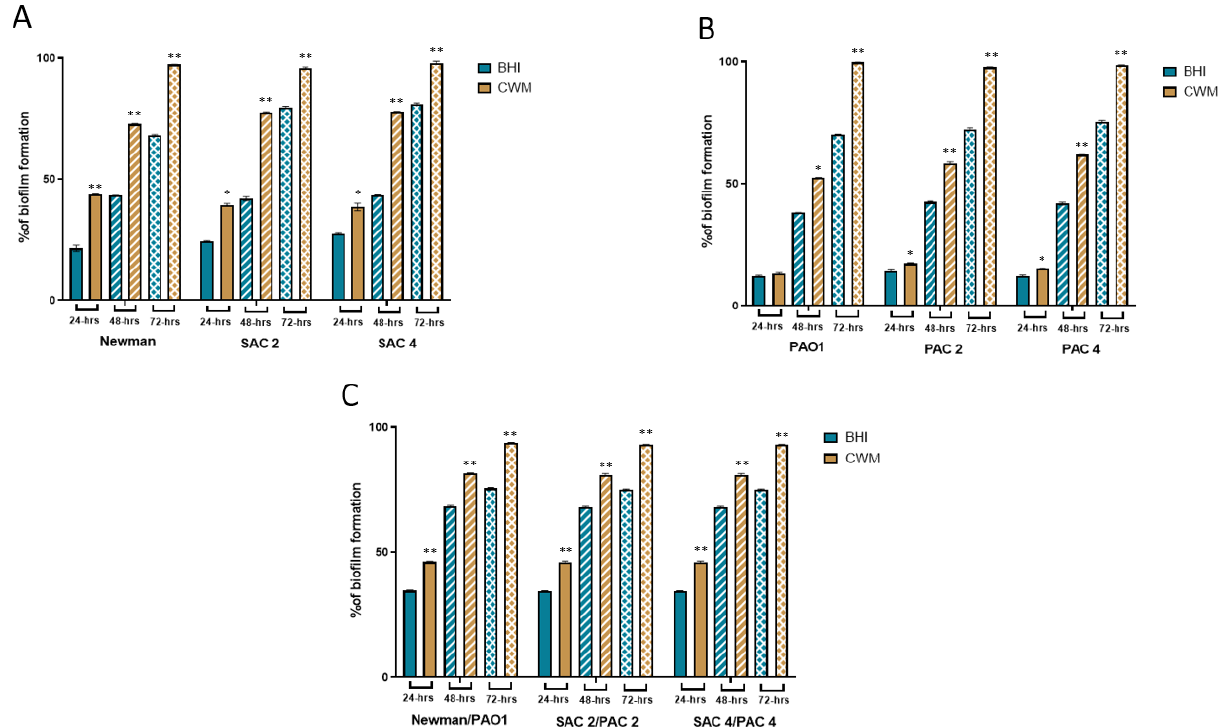
Figure 1. Kinetics of biofilm formation of S. aureus and P. aeruginosa strains used alone or in combina- tion in the BioFlux TM 200 system. ( A ) Percentages of biofilm formed in the microfluidic channel of the reference S. aureus Newman and two clinical S. aureus strains, SAC2 and SAC4, calculated at 24-h, 48- h, and 72-h post-incubation in BHI (blue) and CWM (yellow) media. ( B ) Percentages of biofilm for- mation of the reference P. aeruginosa PAO1 and two clinical P. aeruginosa strains, PAC2 and PAC4 at 24-h, 48-h, and 72-h post-incubation in BHI (blue) and CWM (yellow) media. ( C ) Percentages of biofilm formation of the coculture of P. aeruginosa and S. aureus strains at 24-h, 48-h, and 72-h post-incubation in BHI (blue) and CWM (yellow) media. Percentages of biofilm formation were calculated after three independent experiments and were determined by the software ImageJ. Results are presented as the mean ± standard deviation. Statistics were performed using a t -test on GraphPad Prism version 9.2 to compare the percentage of biofilm formed in BHI and CWM for each time point. * p < 0.1; ** p < 0.01.